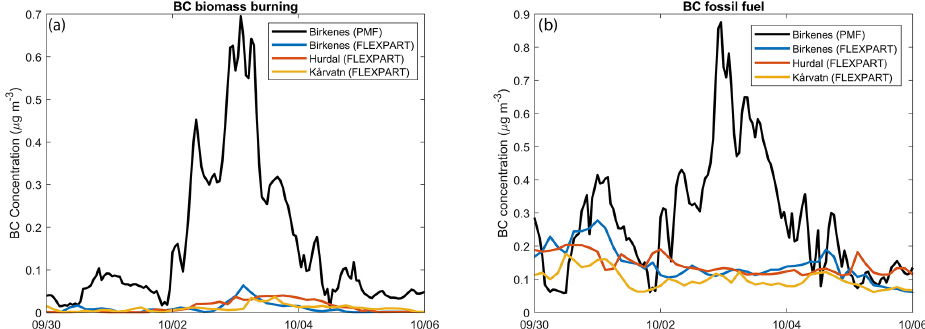
Figure 8. eBC BB (a) and eBC FF (b) concentrations retrieved with PMF from observations at Birkenes (black) and simulated with FLEX- PART at Birkenes, Hurdal, and Kårvatn.